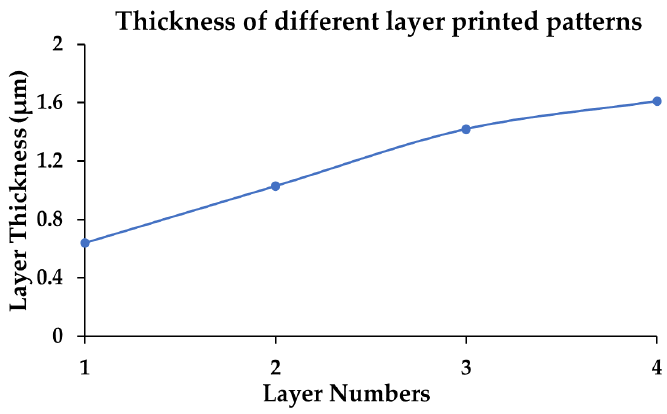
Figure 6. Thickness of printed pattern as a function of printed layers.